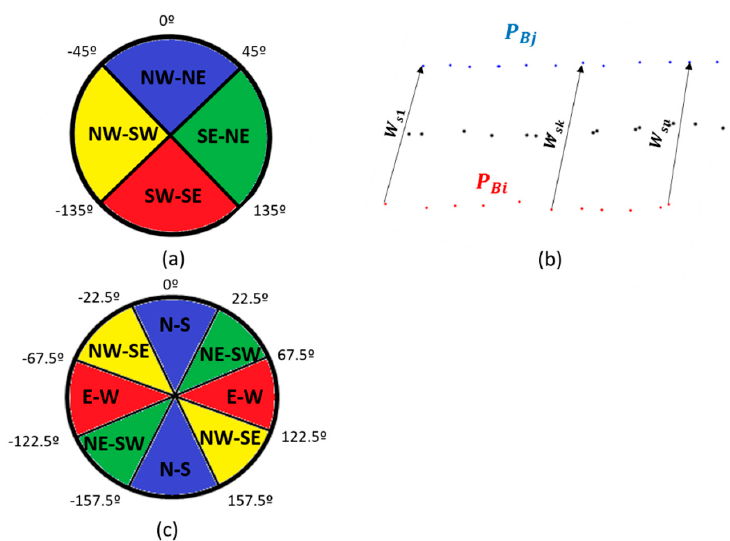
Figure 5. Urban parametrization. ( a ) Façade orientation labels. ( b ) The street width ( W s ) is obtained computing the distance between each point in P Bi and the closest point in P Bj . The street axis is obtained averaging each pair of those points. ( c ) Street orientation labels.